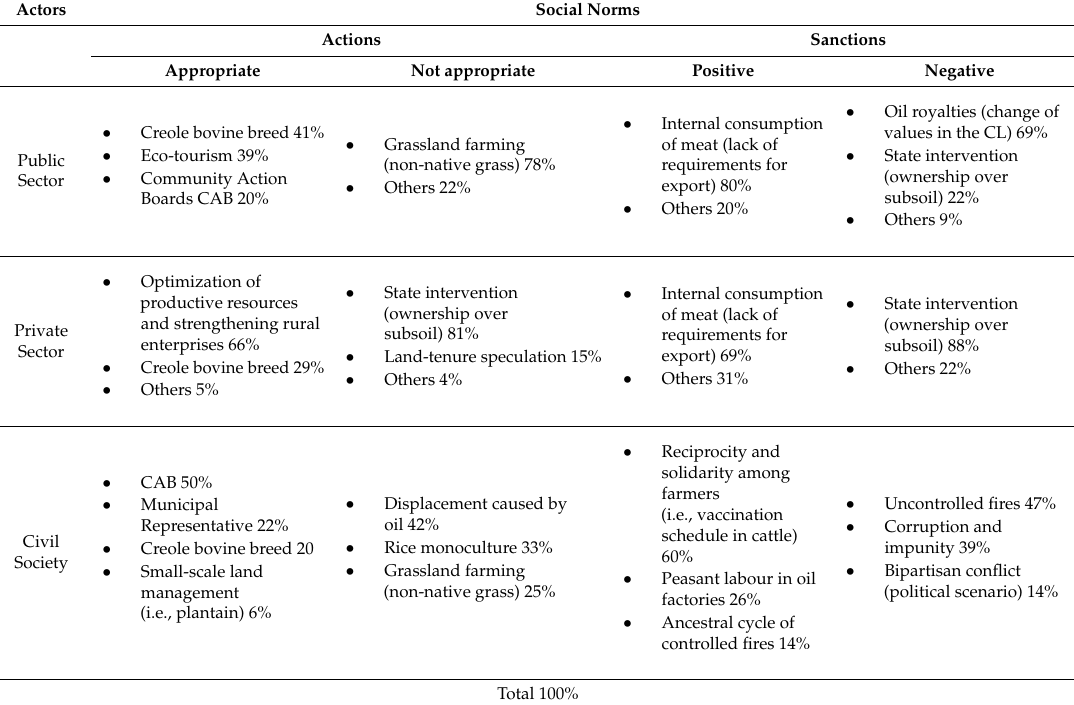
Table 2. The perceived social norms (ranking).